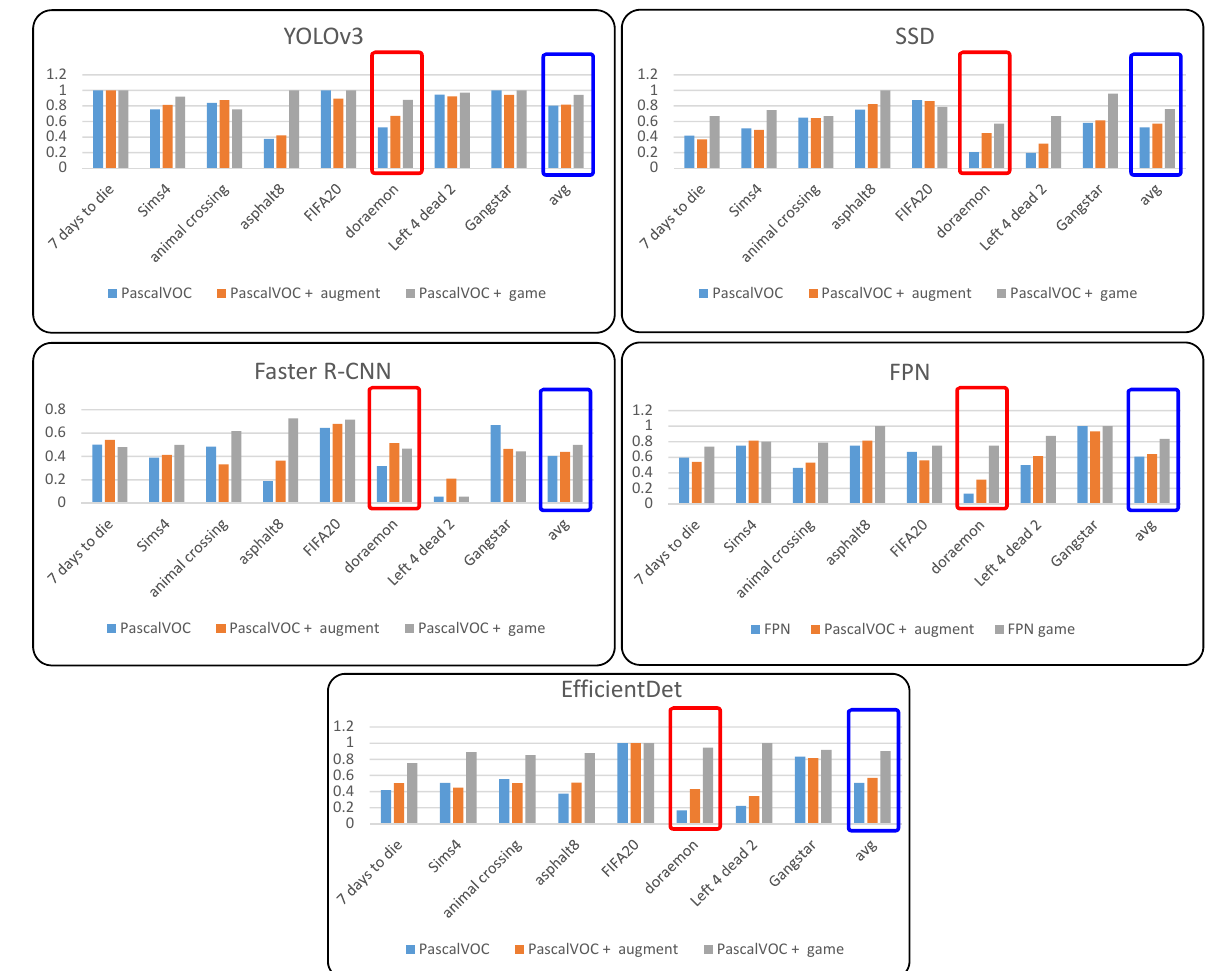
Figure 7. Comparison of three approaches: training only with Pascal VOC, retrained with augmented images and retrained with game scenes. The red rectangle shows comparison of mAPs on scenes from Doraemon , which shows greatest improvement. The blue rectangle shows comparison of average